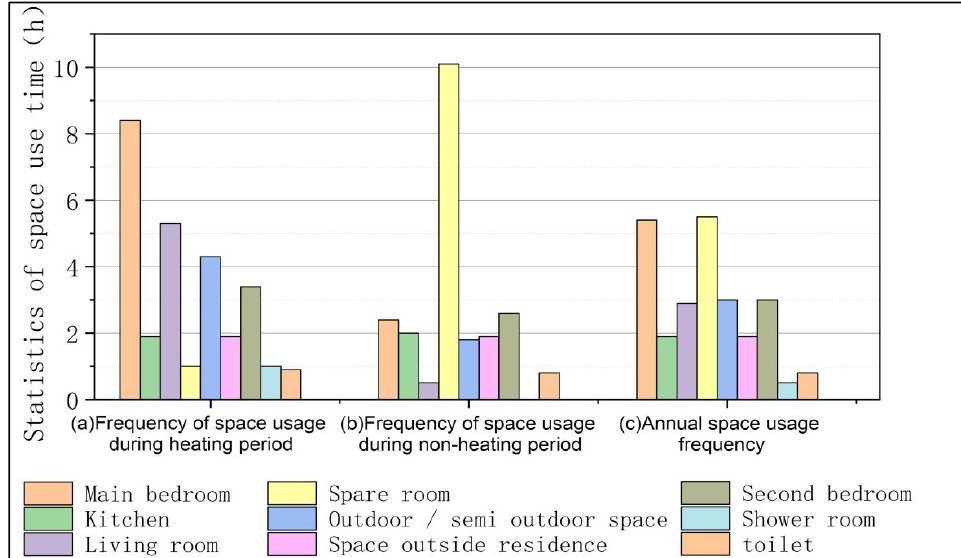
Figure 11. Frequency of space use.